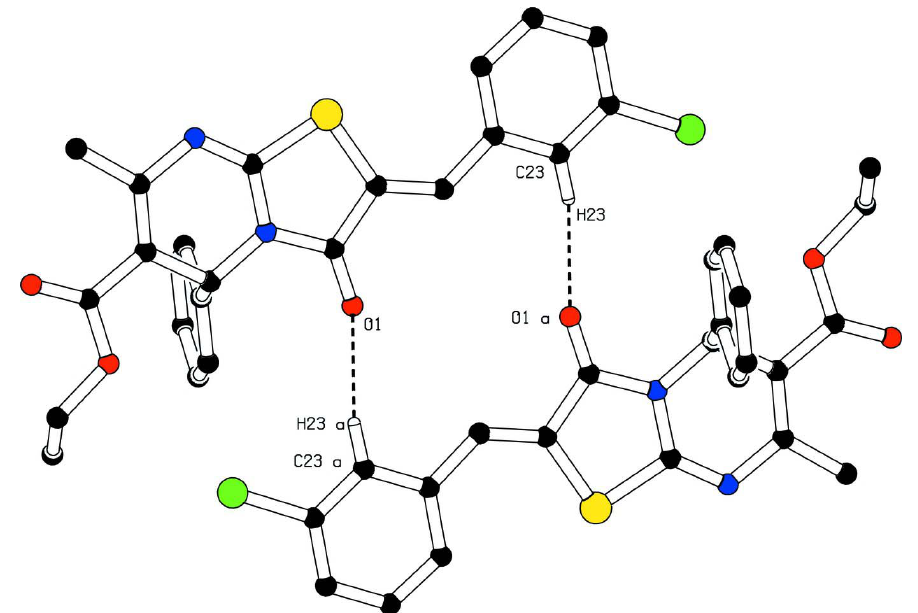
Figure 2 PLATON (Spek, 2003) plot of I showing C—H···O intermolecular interactions and forming R 22 (14) graph–set motif as dashed lines. H atoms not involved in hydrogen bonding have been omitted. Symmetry code (i): -x+1, -y+1, -z.